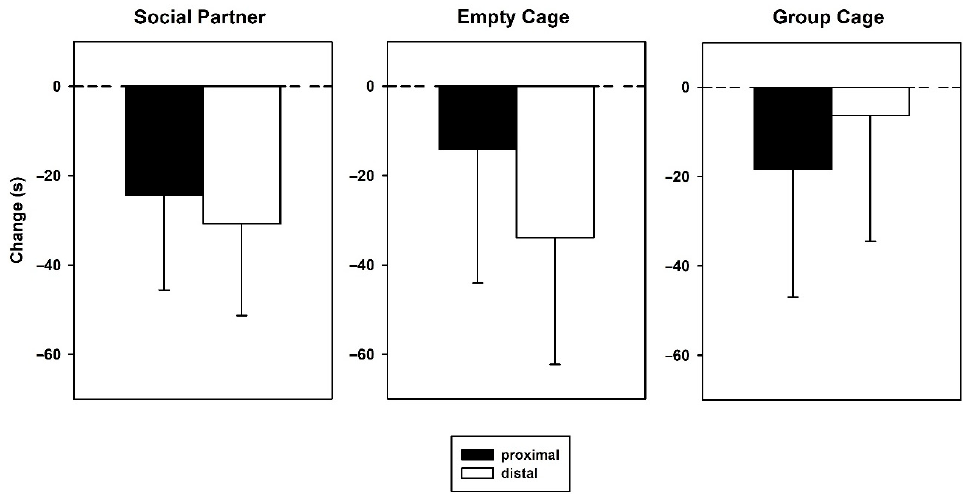
Figure 9. Arm times in the retest expressed as change scores in arms proximal to (black bars) or distal from the sound source (white bars) in animals which had access to a conspecific (Social Partner), no social contact (Empty Cage) or their cage mates (Group Cage) immediately after playback in the initial test. Change scores were calculated for times in arms proximal (black bars) or distal from the sound source (white bars) by subtracting entry and time measures during the 5 min before stimulus presentation from those during the 5 min of stimulus presentation. Data are presented as means + SEM.